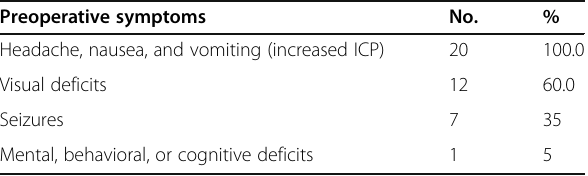
Table 1 The clinical presentations of large intraventricular tumors Preoperative